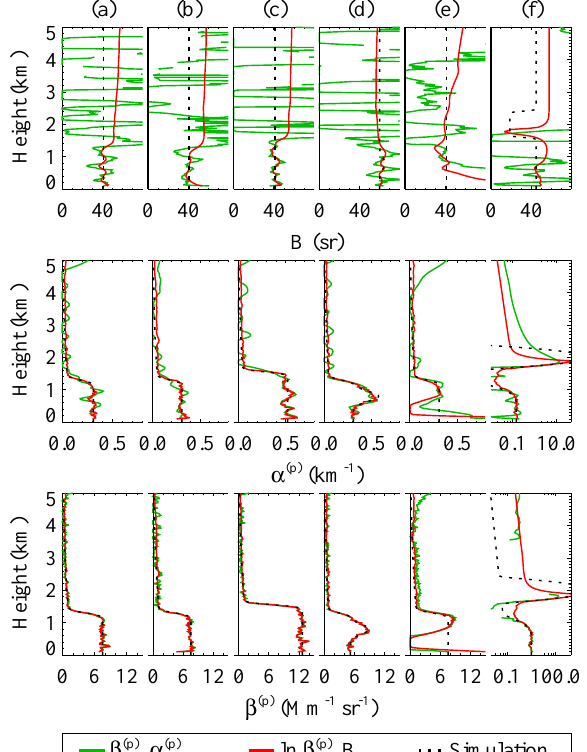
Fig. 5. As Fig. 4 but highlighting the sensitivity to fine-scale fluctu- ations. The blue curve shows the logarithmic retrieval at twice the previous resolution. (g) As (a) , but with the addition of sinusoidal “aerosol layers” of width 300m. (h) As (g) , but width 200m. (i) As (g) , but width 100m. (j) As (a) , but including three overlapping lay- ers. (k) As (a) , but with χ = 0 . 12. (l) As (a) , but with χ = 0 .